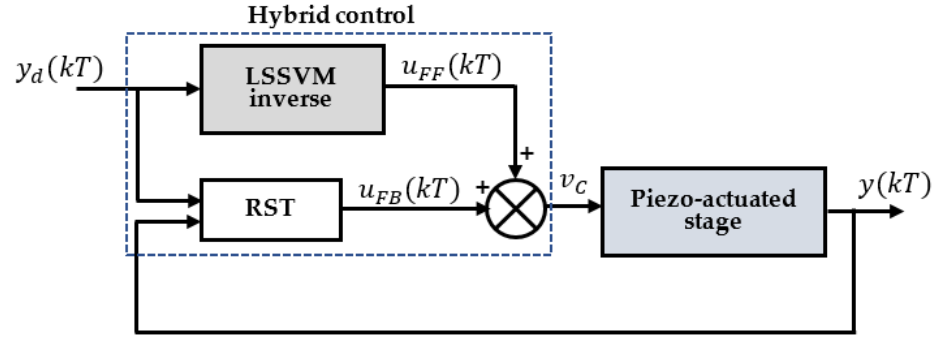
Figure 7. Proposed feedback – feedforward control